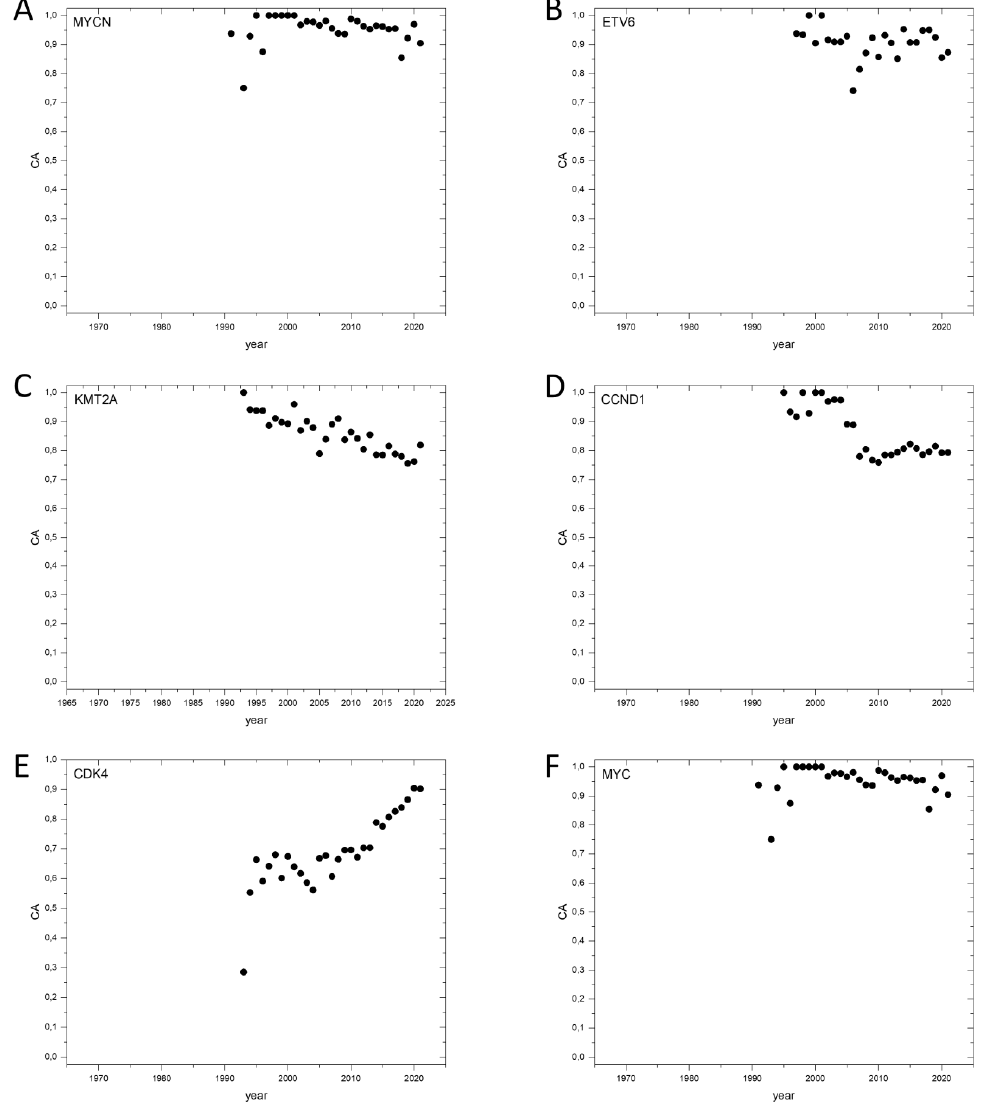
Figure 4. Dynamics of CA (Cancer_Pubs/All_Pubs) parameters of selected human cancer genes defined by Sondka et al., 2018 [17] (CGC ‐ genes). ( A ): MYCN , N ‐ myc proto ‐ oncogene protein. ( B ): ETV6 , G Transcription factor ETV6. ( C ): KMT2A , Histone ‐ lysine N ‐ methyltransferase 2A. ( D ): CCND1 , G1/S ‐ specific cyclin ‐ D1. ( E ): CDK4 , Cyclin ‐ dependent kinase 4. ( F ): MYC , Myc proto ‐ oncogene protein.